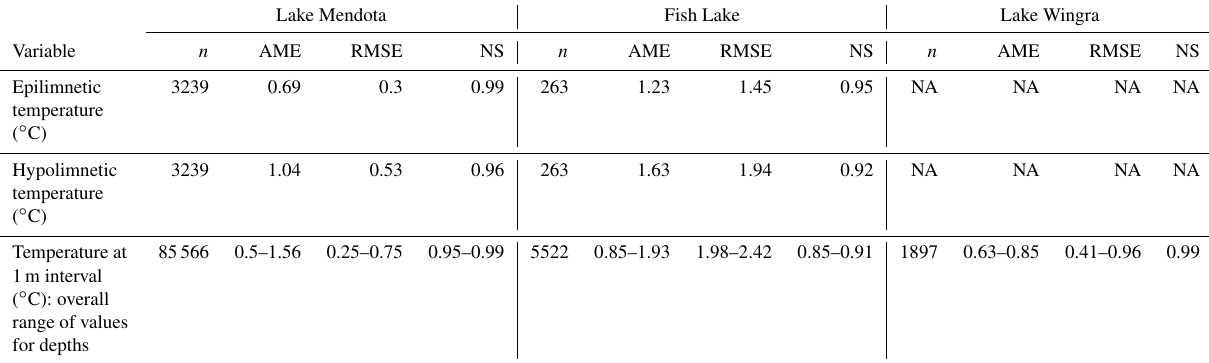
Table 3. Absolute mean error (AME), root mean square error (RMSE), and Nash–Sutcliffe efficiency (NS) for water temperature variables on Lake Mendota, Lake Wingra, and Fish Lake. n indicates the number of measurements; NA represents errors that cannot be determined because Lake Wingra is a polymictic lake and does not have an epilimnion or hypolimnion. Lake Mendota Fish Lake Lake